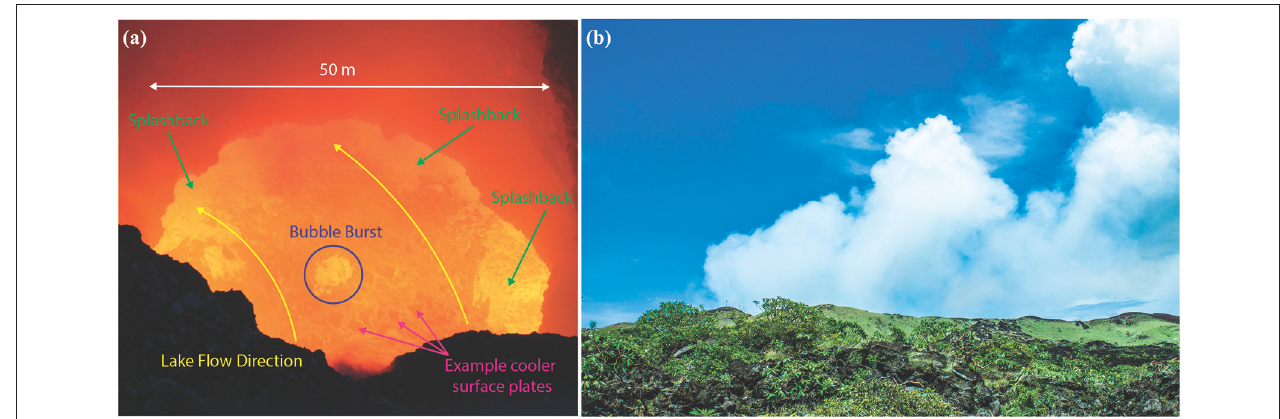
FIGURE 1 | (a) An overview of the features of Masaya lava lake during our period of measurement in June 2017, and (b) an image of typical conditions during the